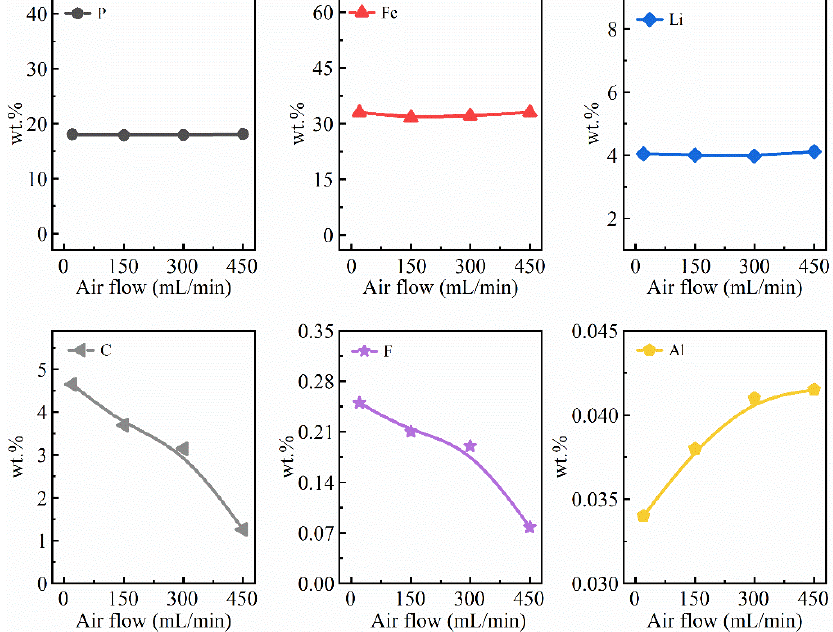
ff erent air flow